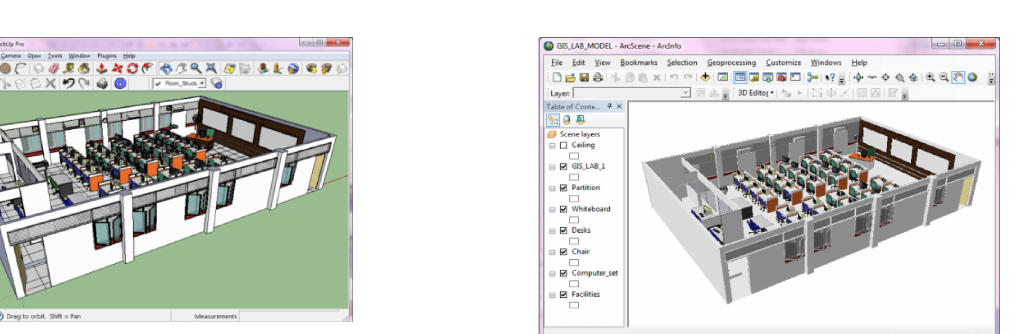
Figure 13. The complete model of GIS Lab 1 displayed in